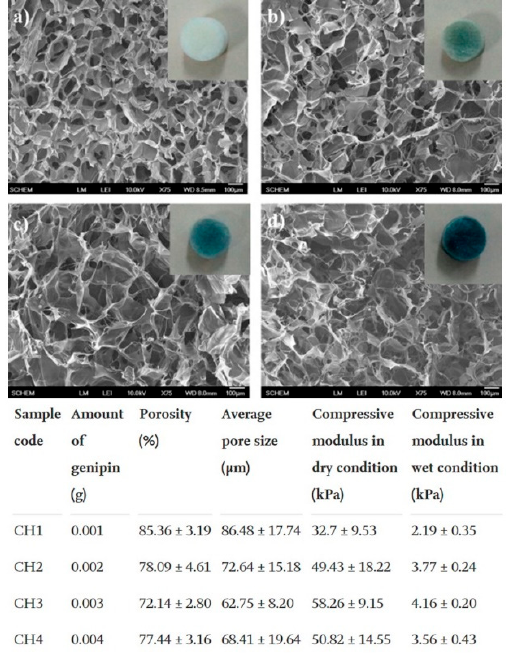
Figure 8. SEM images of only chitosan ( a ), CH1 ( b ), CH3 ( c ), CH4 ( d ) sca ff olds. See table below Figure 8 . SEM images of only chitosan ( a ), CH1 ( b ), CH3 ( c ), CH4 ( d ) scaffolds. See table below for for material details and mechanical properties. The sca ff old is structured by chitosan, whereas the material details and mechanical properties. The scaffold is structured by chitosan, whereas the extracellular matrix (ECM) part is obtained by HA. Images of each type of sca ff old (cylindrical shape extracellular matrix (ECM) part is obtained by HA. Images of each type of scaffold (cylindrical shape with 1 cm in diameter) have been shown inset. From with 1 cm in diameter) have been shown inset. From [62].